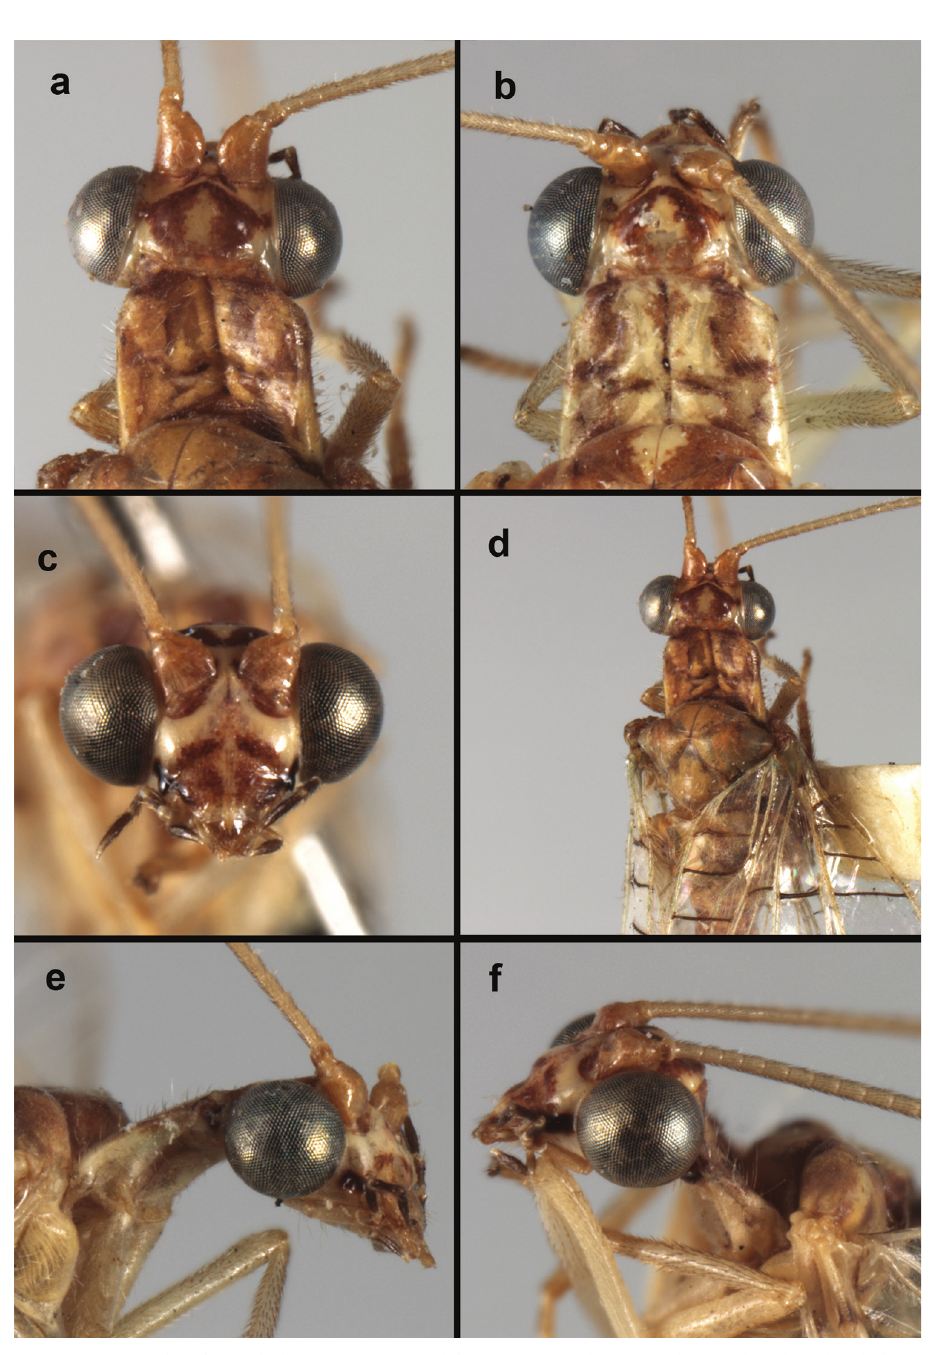
Figure 85. Ungla siderocephala (Navás): External features, ( a, b ) head, prothorax, dorsal ( c ) head, fron- tal ( d ) head, thorax, dorsal ( e, f ) head, prothorax, lateral (all: Peru; a, d Huaral, female, CAS; b La Samme, female, CAS; c, e, f La Samme, male,